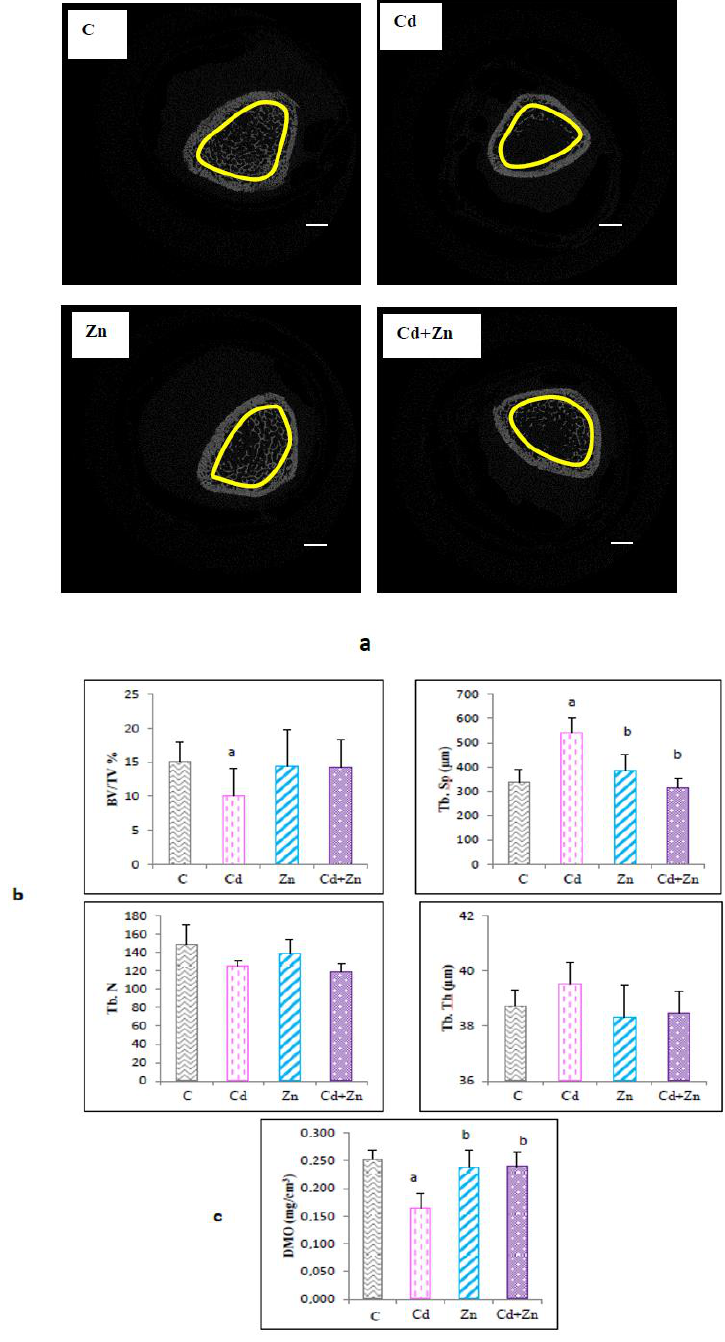
Figure 9. ( a ) Cross-sectional micro-computed tomography reconstruction was performed on distal femur ((scale bar: 1mm) of rats (PND70) from control females and rats from females exposed to cadmium (50 mg/L Cd as CdCl2) and / or zinc (60 mg/L Zn as ZnCl2) during gestation and lactation, ( b , c ) Trabecular bone volume (%BV/TV), trabecular number (Tb.N), trabecular thickness (Tb.Th), trabecular separation (Tb.Sp) were measured and BMD was determined on femur sections. Values are expressed as mean ± SEM from 7 samples. a ( p < 0.05); significant difference compared to the control group (C); b ( p < 0.05); significant difference compared to the Cd group (Cd).